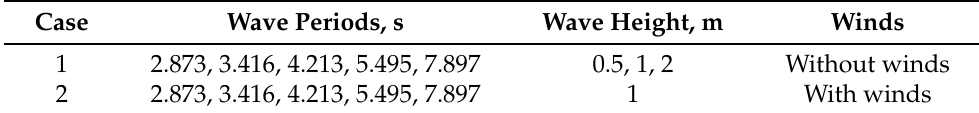
Table 3. The regular wave parameters used for tests.